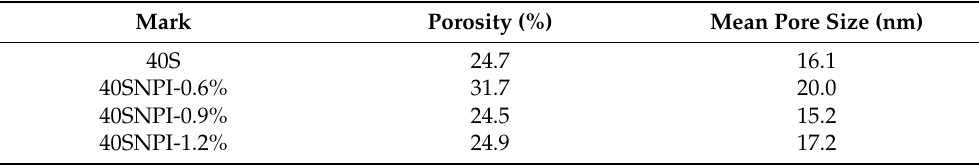
Table 4. The total porosity and the mean pore size of cement pastes calculated by